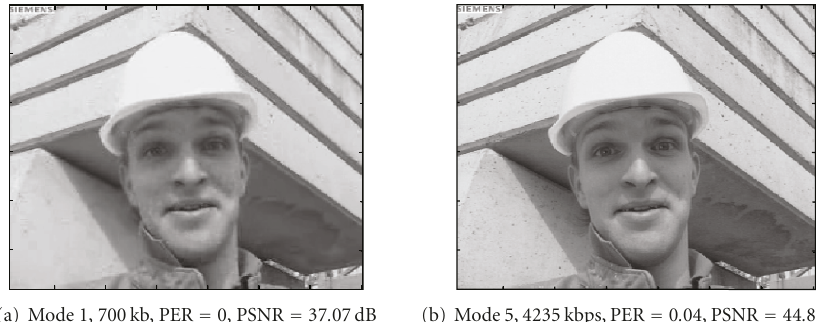
Figure 4: Foreman sequence, frame 30, C/N = 18dB.